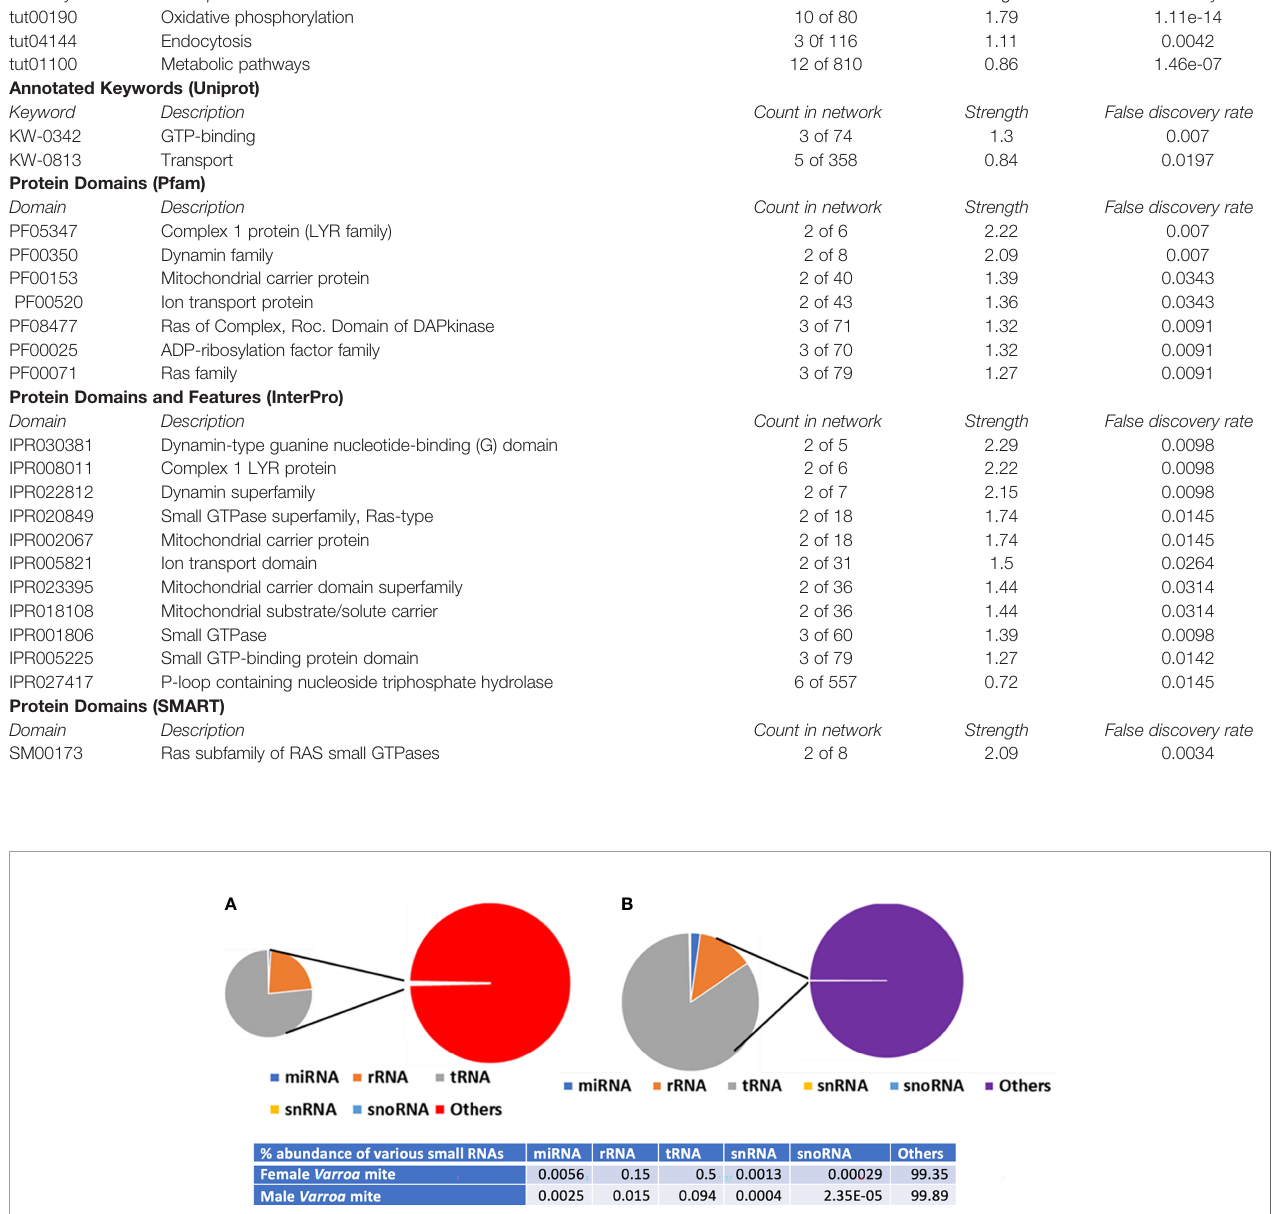
Frontiers in Cellular and Infection Microbiology |